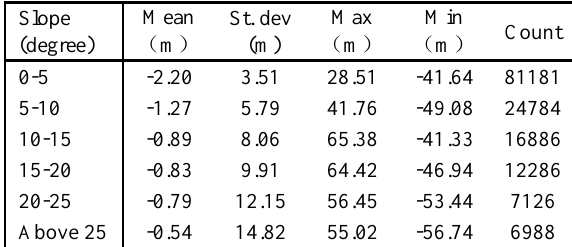
Table 2. Statistics of DEM 2007 minus SRTM DEM